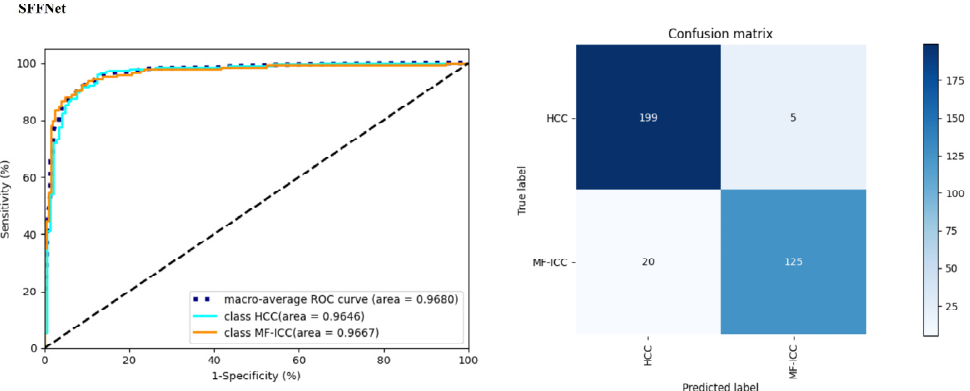
Figure 7. The left is the receiver operating characteristic curve (ROC ) and the right is confusion matrix of the SFFNet model (the blue line indicates the ROC of HCC, the orange line is the ROC of MF ‐ ICC, and the dashed line is the overall ROC).